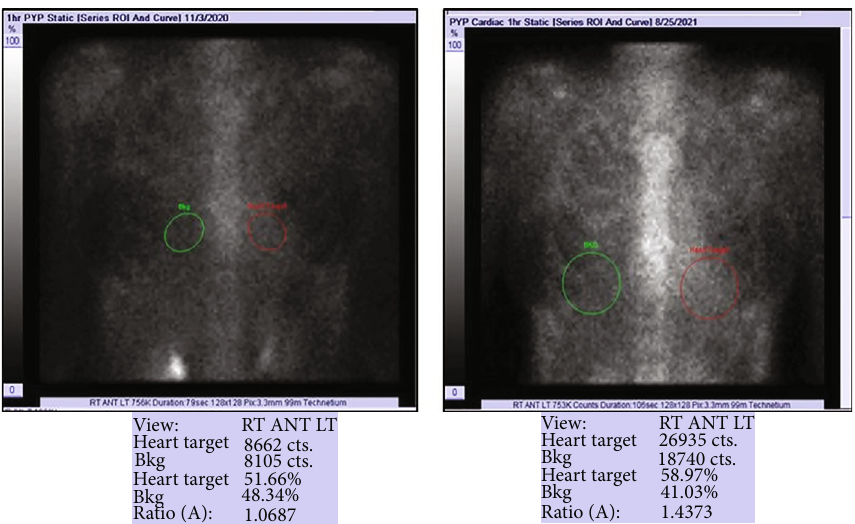
Figure 4: Right PYP scan showed increased PYP uptake compared to the left PYP scan done almost a year earlier.